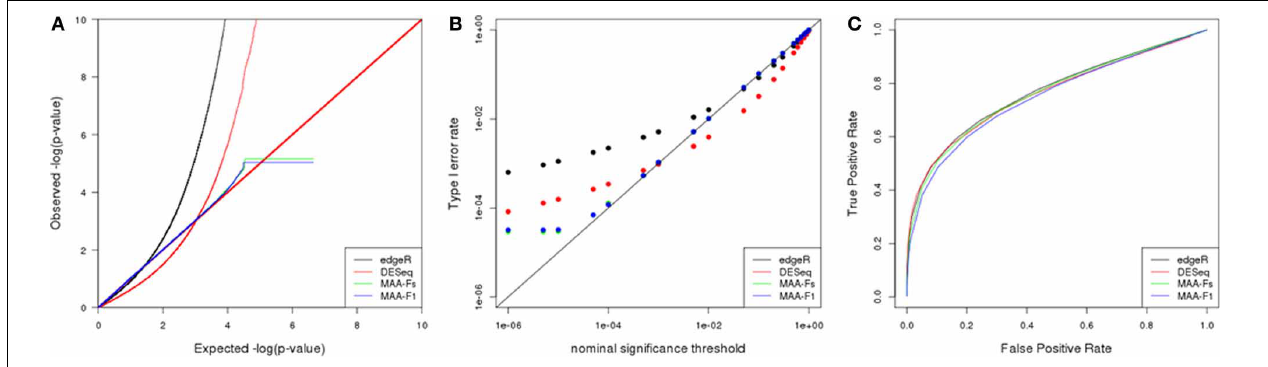
FIGURE 5 | Simulation results from a scenario with 3 biological replicates: (A) Q–Q uniform plot of non differentially expressed transcripts, (B) type I error rate vs. nominal significance values, and (C)